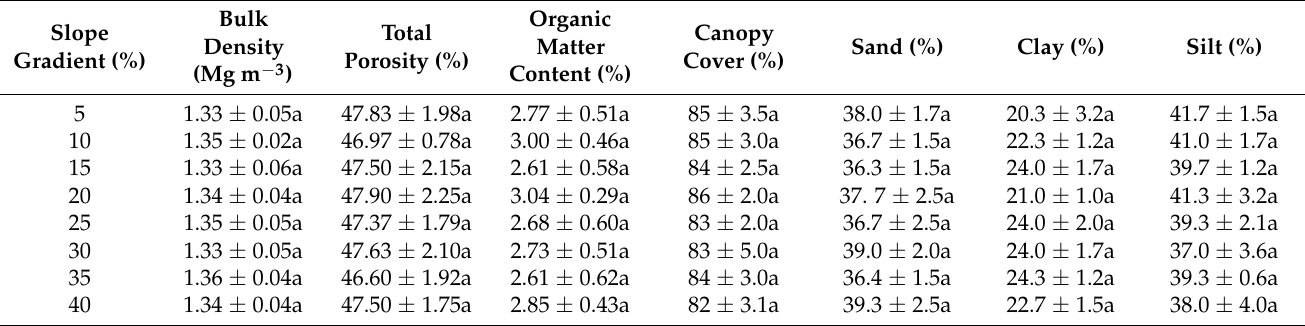
Table 2. ANOVA results (Mean values ± sd) of different soil physical properties before the experiment started in 2015 in the runoff sample plots with different slope gradients (i.e., 5, 10, 15, 20, 25, 35, 30, and 40%). Slope Gradient